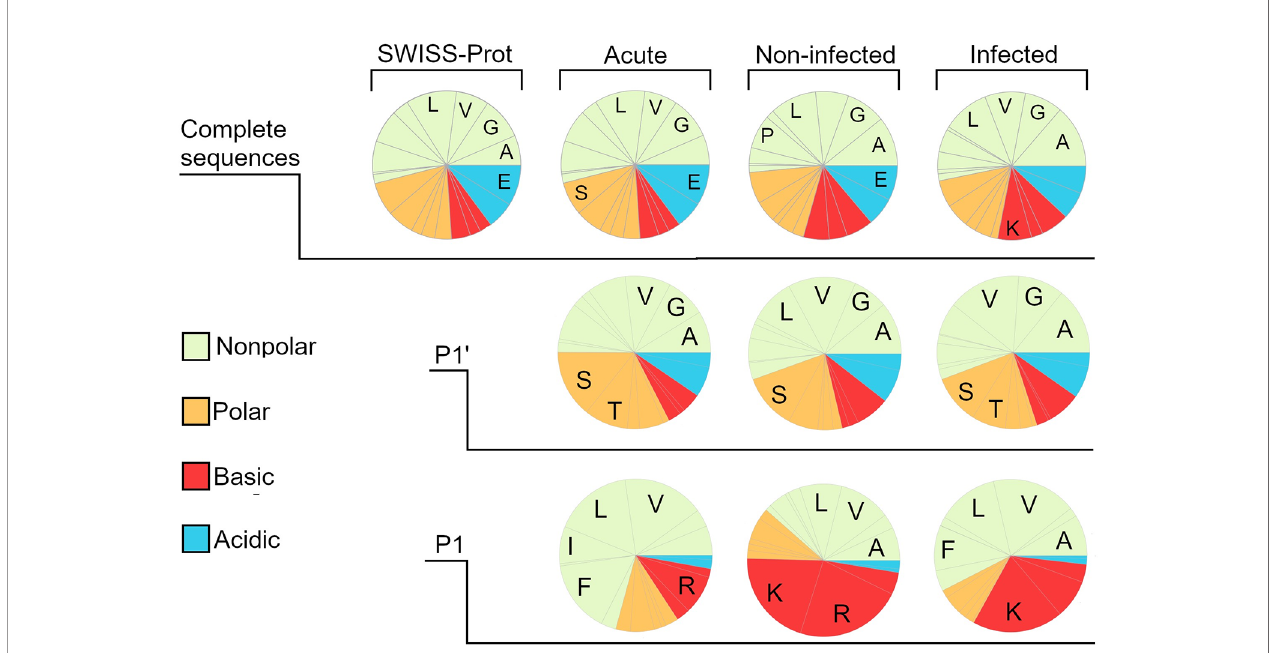
FIGURE 3 | Amino acid composition of the different wound fl uid peptidomes. Pie charts created by frequency analysis of amino acids in the complete sequence, weighting the results by the relative quantity (spectral count) of the peptides. Similarly done for the last position (P1 ’ ) and fi rst position (P1) but excluding those peptide sequences corresponding to the protein substrate inherent N- and C-terminal, since they are not generated by proteases. For reference, a pie chart was made by using data on the whole SWISS-prot database, showing a distinct similarity regarding the amino acid distribution in whole sequences. The most noticeable difference between the different groups can be seen when looking at the P1 position, showing a much larger proportion of acidic amino acids in both the infected and non-infected. The fi ve most prominent amino acids are denoted by one-letter